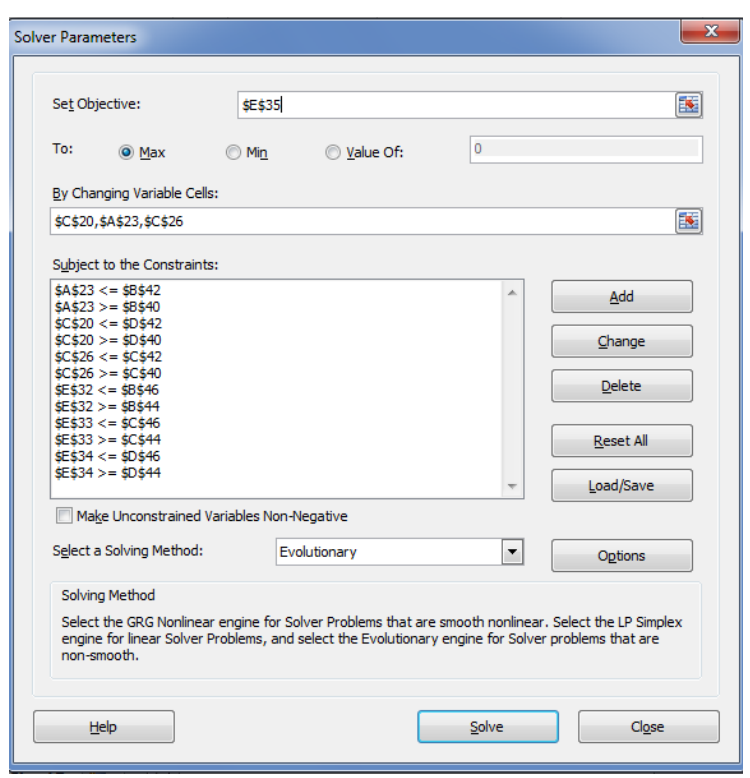
Figure A2. The solver parameters.